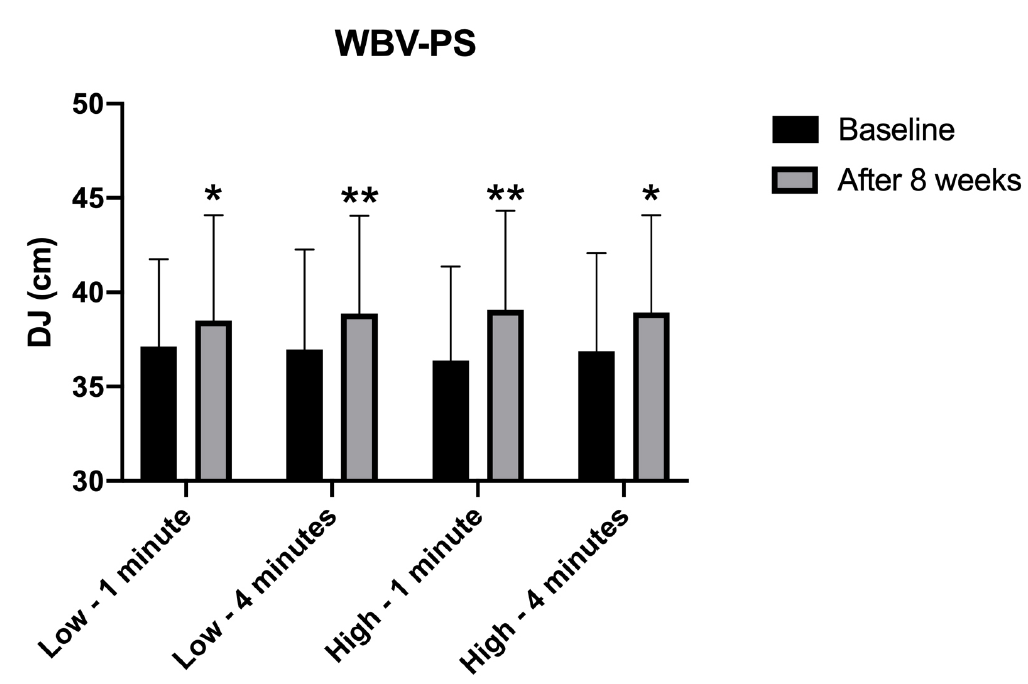
FIGURE 5. Differences between baseline and after post-activation potentiation protocols attending to volume and rest for drop jump (DJ) in parallel squat onto a whole-body vibration platform (WBV-PS). * Significant differences ( p < 0.05) when comparing post-protocol results with baseline; ** Significant differences ( p < 0.001) when comparing post-protocol results with